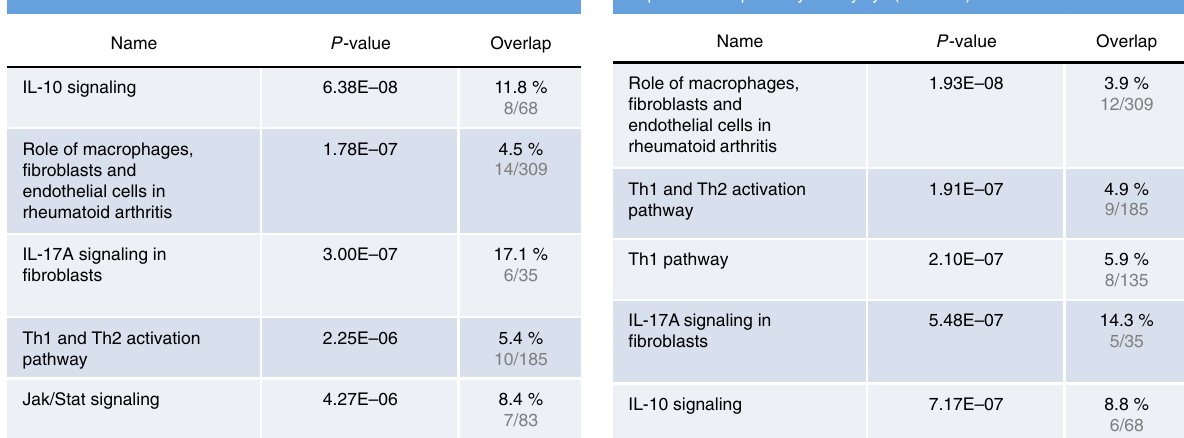
Fig. 3 Microarray analysis of Ba/F3-SyCyR(IL-23/2A) cells. a Venn-diagram of at least 1.5-fold ( p -value ≤ 0.01) up- or downregulated mRNAs of Ba/F3- SyCyR(IL-23/2A) cells stimulated with 100 ng/ml GFP-mCherry (light gray) and Ba/F3-IL-12R β 1-IL-23R cells stimulated with 100 ng/ml HIL-23 (dark gray) for 60 min. Microarray analysis was performed using samples of four independent biological replicates. b Heat map comparing mRNA levels of Ba/ F3-SyCyR(IL-23/2A) and Ba/F3-IL-12R β 1-IL-23R stimulated and unstimulated as described in a . c Higher magni fi cation of selected mRNAs from b .